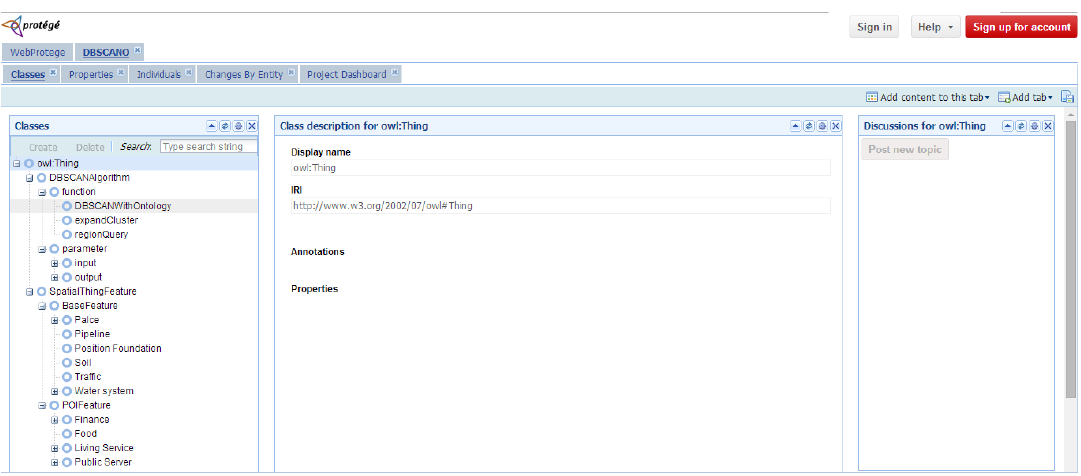
Figure 6. Snapshot of part of hierarchy of DBSCANO in WebProtégé .